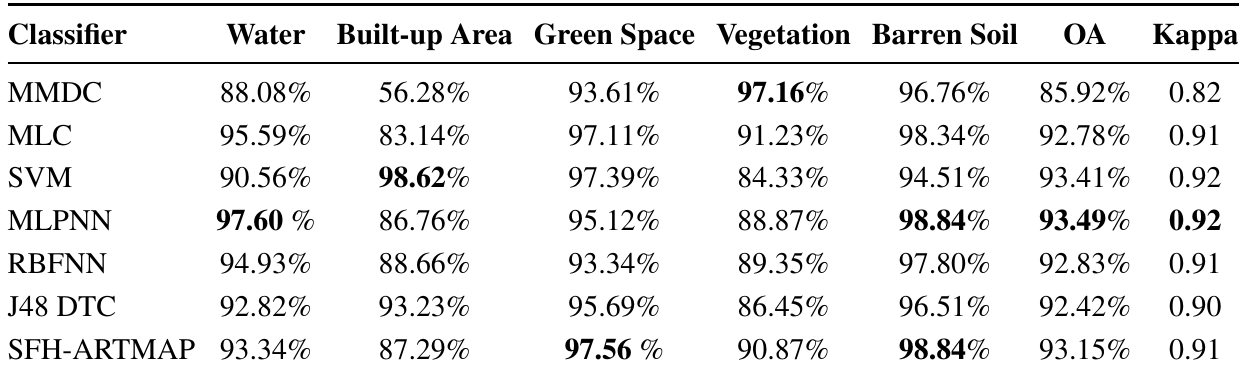
Table 3. Classification accuracy of the second scheme (spectral and textural features).